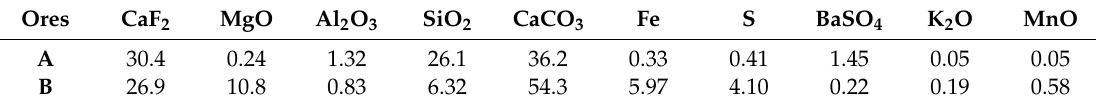
Table 2. Chemical analysis of the fluorspar ores A and B.